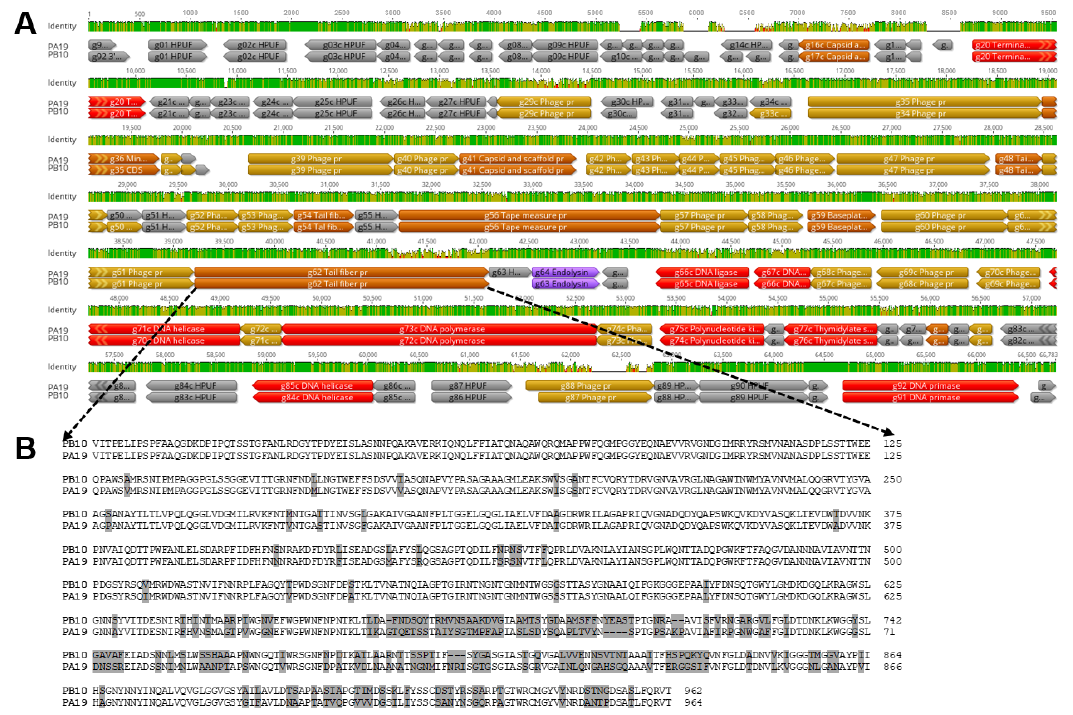
Figure 3. Genome comparison of phages PB10 and PA19. Panel ( A ). Alignment of the genomes. The DNA-identity-% is indicated by the “Identity” track with 100% identity, indicated by green color, while the height of the graph indicates the identity%. The alignment was generated by the Geneious version 2022.2.2 using the Clustal Omega vs. 1.2.2. Panel ( B ). Alignment of amino acid sequences of the Gp62 tail fiber proteins demonstrating the lower similarity between the C-terminal thirds of the proteins; the differences are highlighted in grey.